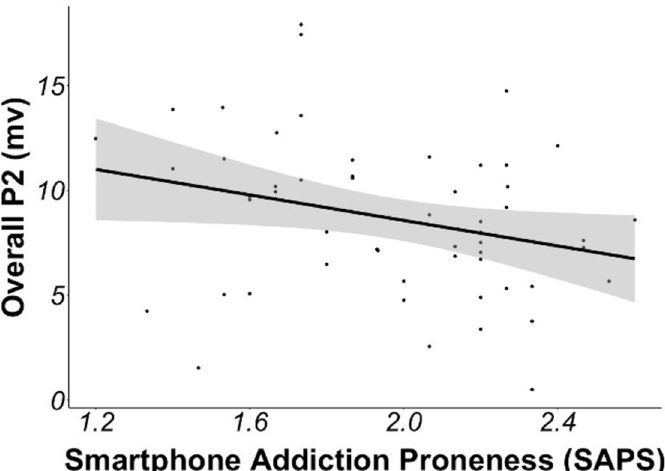
Fig 7. Correlation between smartphone addiction and P2 ERP. Correlation between smartphone addiction proneness and the overall P2 mean amplitude (P2 at site Fz within the 150–210 ms time window), indicating that people with higher levels of smartphone addiction show reduced neural activation implicated in early attentional mechanisms.